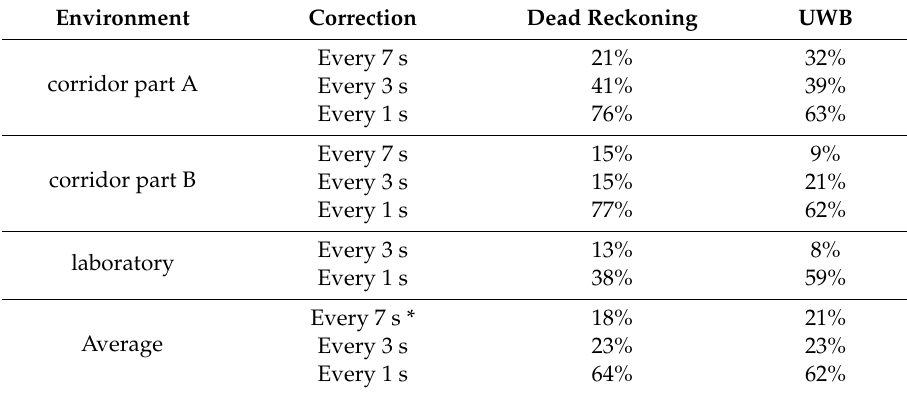
Table 4. The improvement using systematic